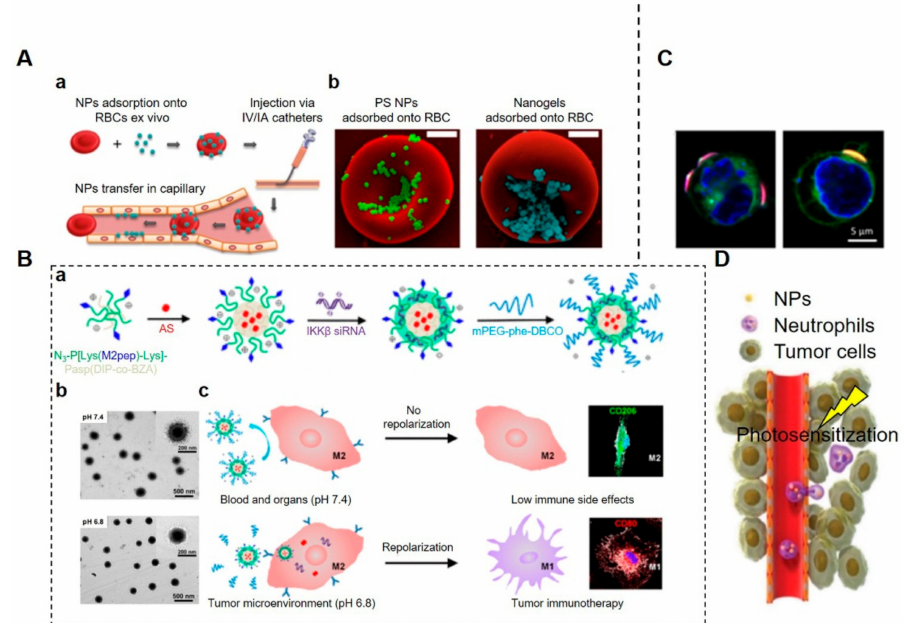
Figure 3. Mammalian cells for targeted drug delivery. ( A ). RBC hitchhiking (RH) drug delivery system. ( Aa ) Procedural steps of RH. NPs were first adsorbed onto the RBCs ex vivo. The RBC–NP complexes were then injected intravenously (IV) or intra-arterially (IA). Then, RH transferred NPs to the capillaries of the first downstream organ. ( Ab ) SEM images of polystyrene NPs (PS-NPs) and nanogels attached to the surface of murine RBCs [100]. NPs were mixed with RBCs in vitro. Scale bars = 1 µ m. ( B ). M2-like tumor-associated macrophage (TAM)-targeted NPs. ( Ba ) Composition and structure of a self-assembled micelleplex. The amphiphilic diblock copolymers self-assembled into M2-targeting micelles with therapeutic agents. ( Bb ) TEM images of a micelleplex at pH 7.4 and pH 6.8. At pH 6.8, the size of the micelleplex decreased due to the removal of the sheddable PEG corona. ( Bc ) Schematic illustration of PEG-sheddable nanodrug targeting M2-like TAMs for tumor immunotherapy [102]. The pH-sensitive nanodrug with M2-targeting peptide (M2pep) was coated with a sheddable PEG corona. It was stable at pH 7.4 but cleavable in the acidic tumor microenvironment (TME) for active M2 targeting. A STAT6 inhibitor, AS1517499 (AS), and IKK β siRNA were exposed for M2-to-M1 transpolarization for cancer immunotherapy. ( C ). Confocal micrographs of cellular backpacks attached to the surface of leukocytes (nucleus, blue; membrane, green; backpack, red) [103]. ( D ). Schematic illustration of neutrophil-mediated delivery of NPs to inflammatory tumor tissues induced by photosensitization (PS) [104]. Firstly, anti-CD11b antibody- coated NPs (NPs-CD11b) were constructed via biotin–neutravidin binding. Then, neutrophils were activated after tumor PS treatment and the intravenously injected NPs-CD11b were internalized by active neutrophils. Finally, NP-laden neutrophils infiltrated the tumor for drug delivery. (Image ( B )